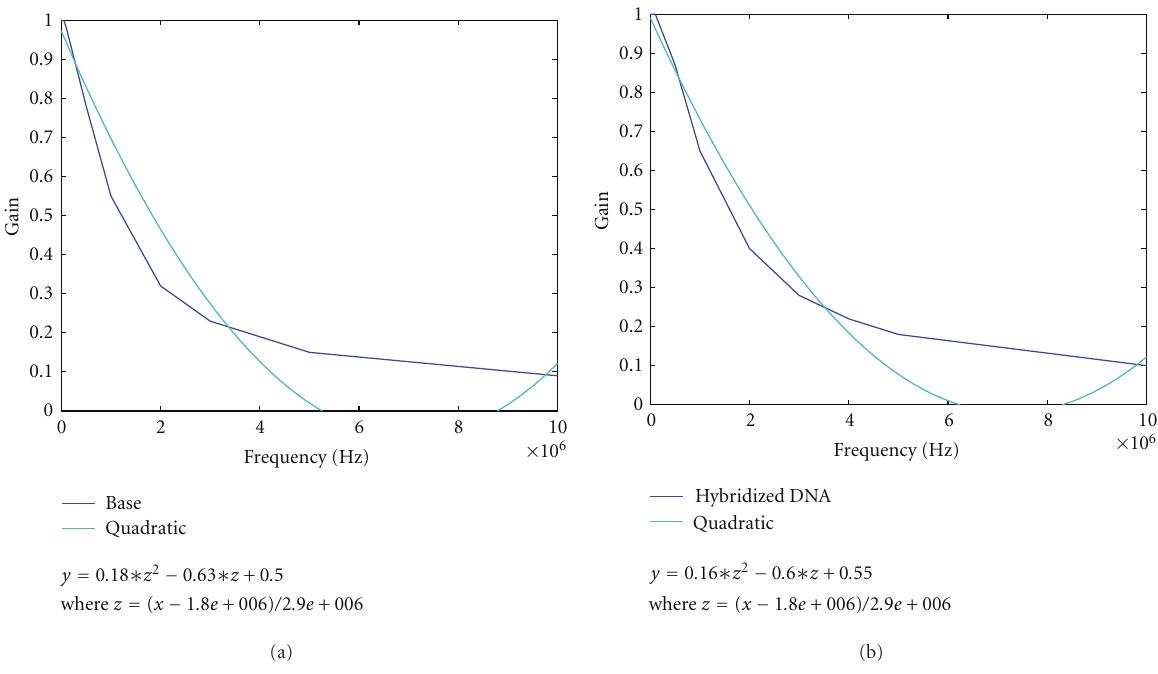
Figure 8: (a) and (b) represent the curve fitting technique applied on the 2.52 K Ω bare and hybridized Sensor, respectively. Equations below the respective figures represent the gain-frequency relationship. Using the above equations, the capacitance for the sensor with known resistance (2.52 K Ω ) was calculated, and it was closely comparable with the designed value of capacitance. Table 2 represents the designed and calculated